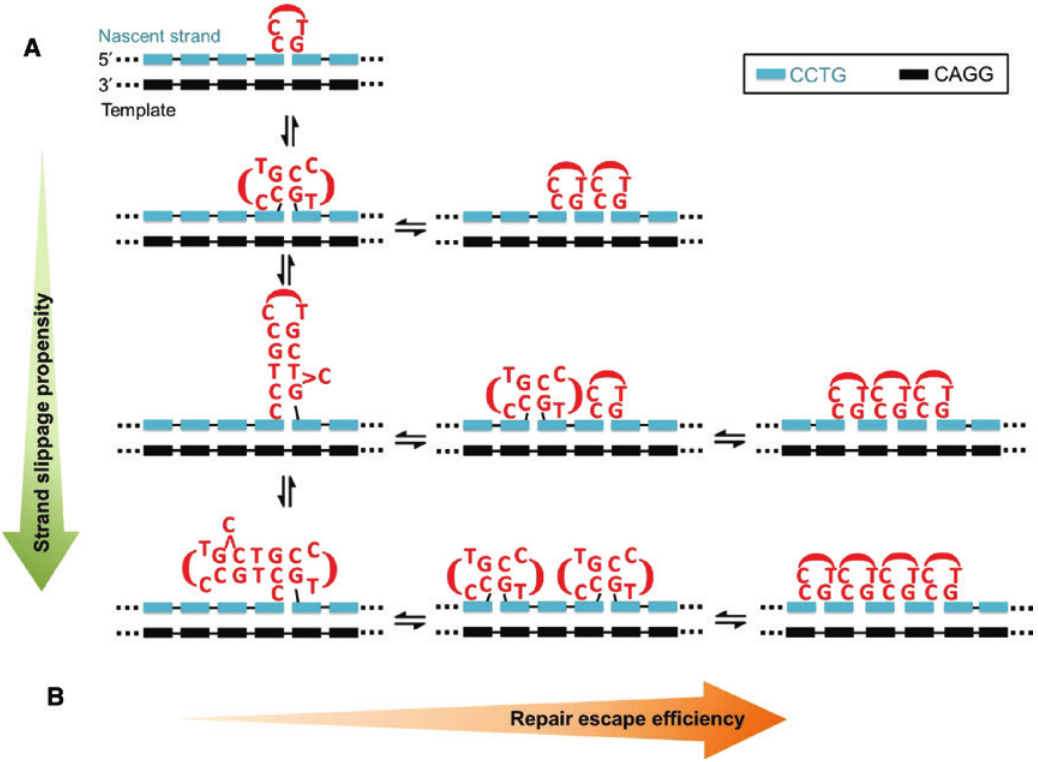
Figure 7: Interconversion between different types of unusual CCTG structures. (A) Conversion to a larger and more stable unusual structure will lead to a higher propensity of strand slippage. (B) Conversion from a larger unusual structure to multiple smaller structures will bring about more efficient repair